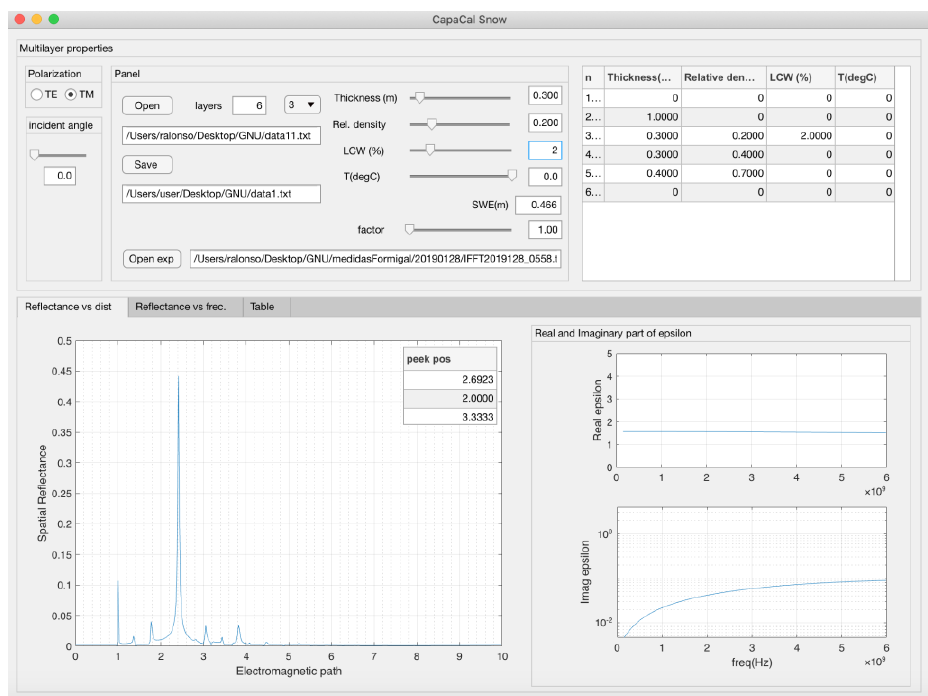
Figure 4. Software developed to calculate the time signal of radar for a snowpack, including the density, wetness, and frequency of all layers. (Adapted with permission from ref. [30]. Copyright 2020 IEEE).